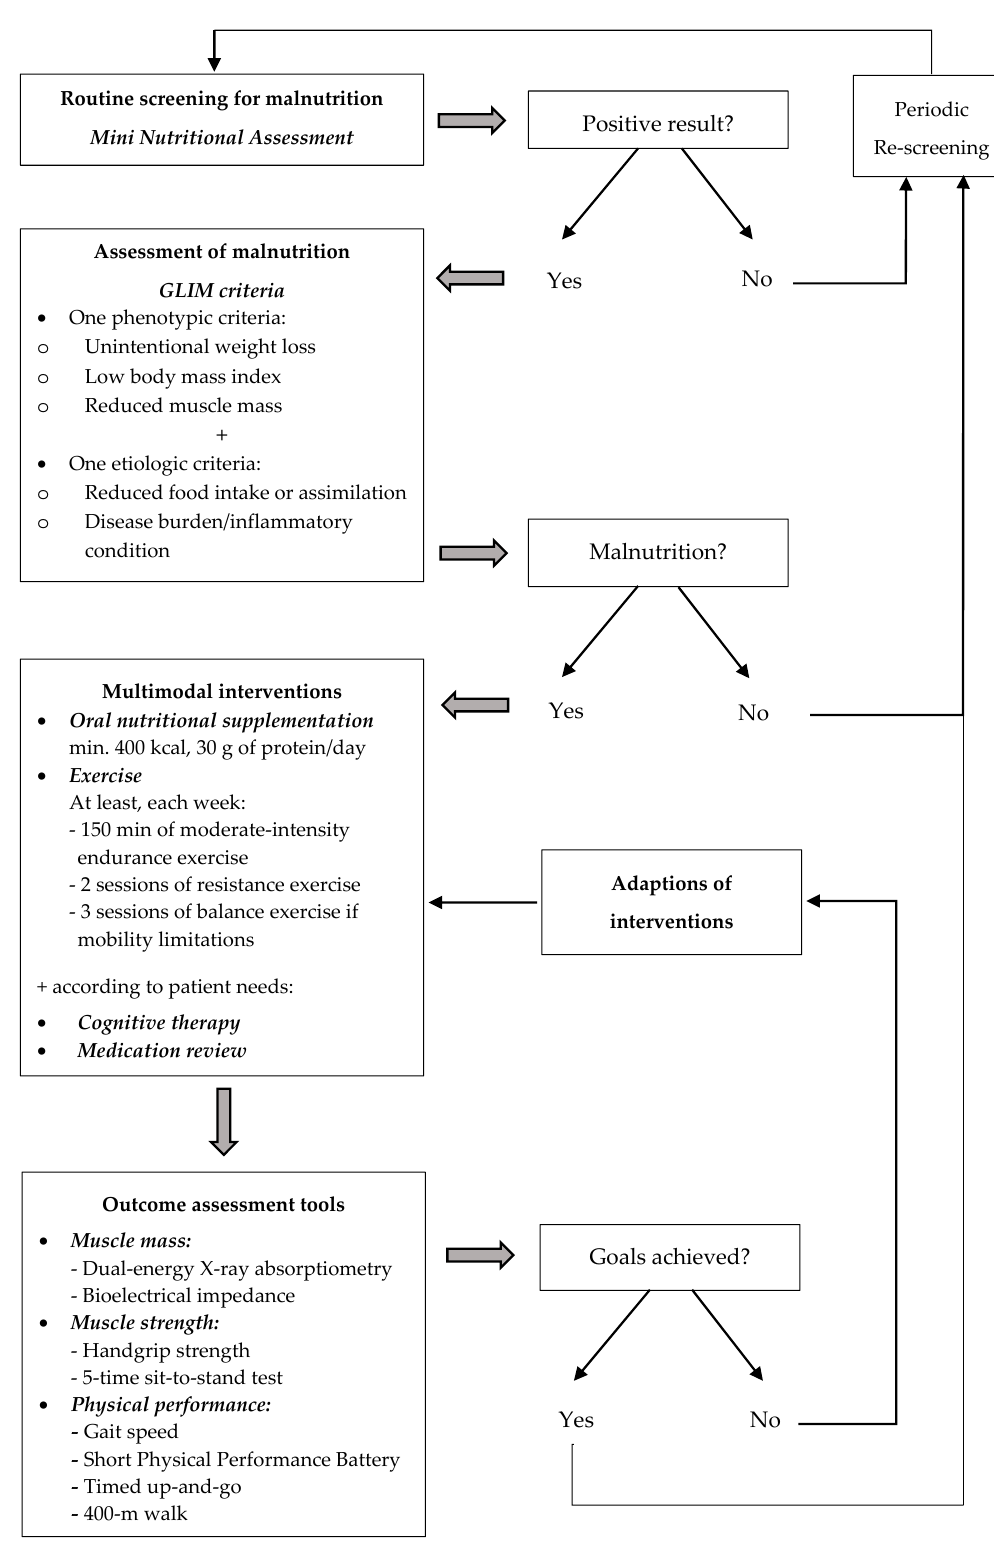
Figure 2. Nutritional management in community-living older